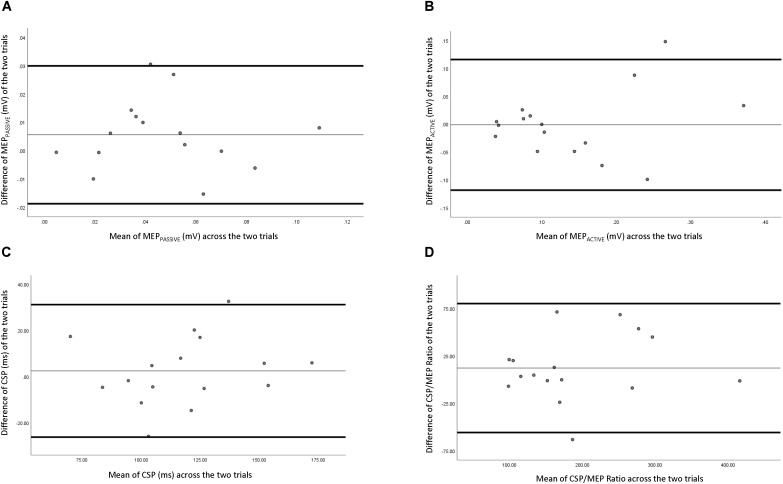
Bland–Altman plot of corticospinal measures across two testing sessions. (A) Passive motor evoked potential, (B) active motor evoked potential, (C) corticospinal silent period, and (D) ratio of corticospinal silent period and active motor evoked potential.